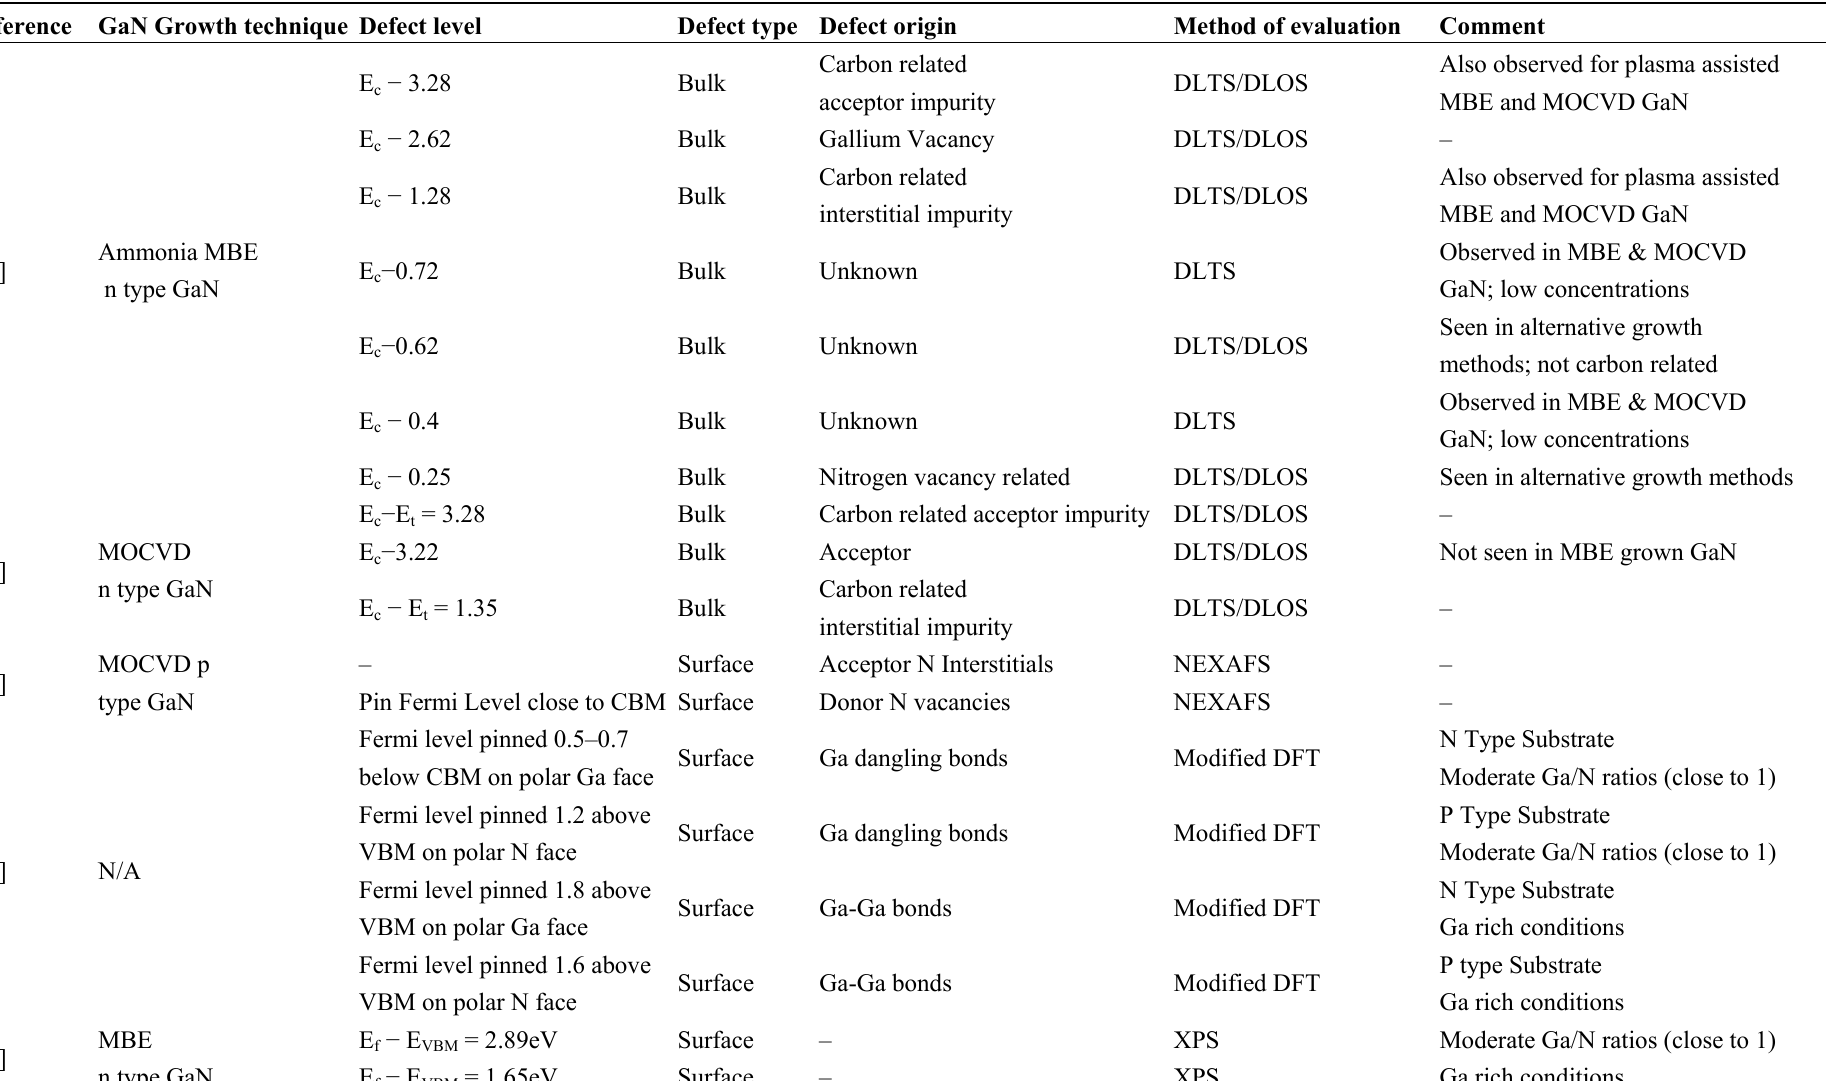
Table 1. Summary of relatively recent literature on the defect energy levels presented in this